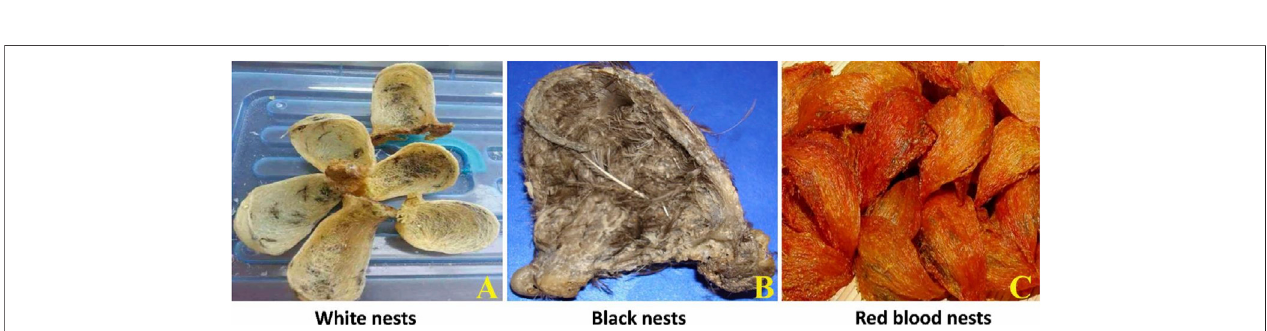
FIGURE 2 | An overview of white (A) , black (B) and red (C) EBNs.